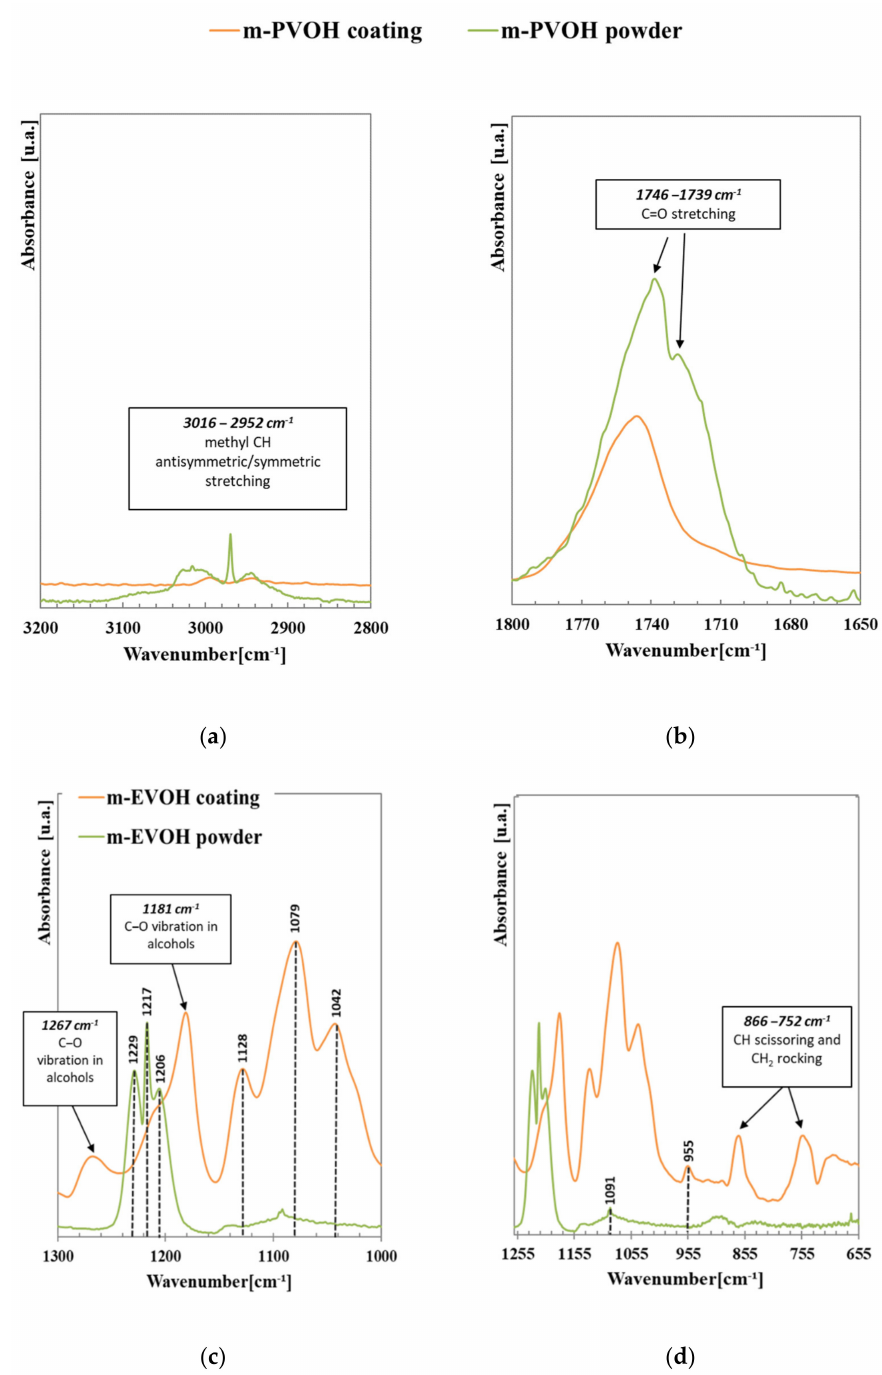
Figure 2. ( a – d ) ATR-FTIR spectra magnification of m-PVOH powder (green line) and m-PVOH thin coating layer (red